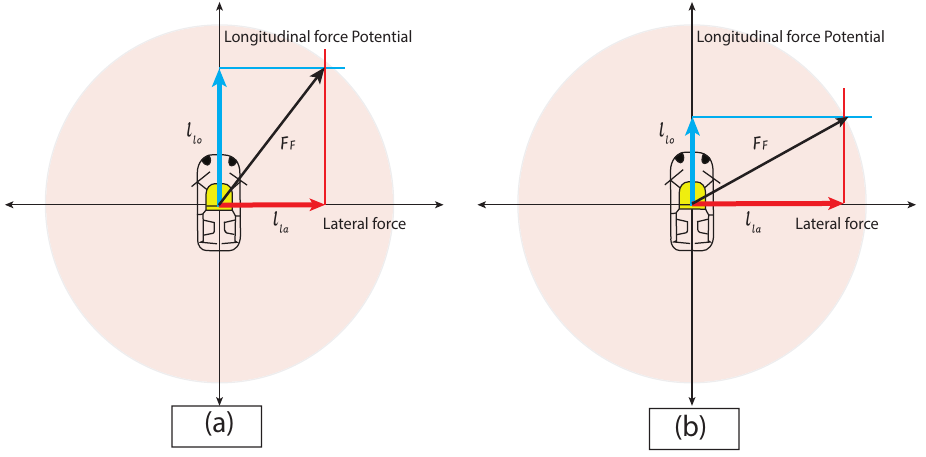
Figure 7. Overall force is limited to F f . ( a ) An increase in longitudinal force limits the lateral force. ( b ) An increase in lateral force limits the longitudinal